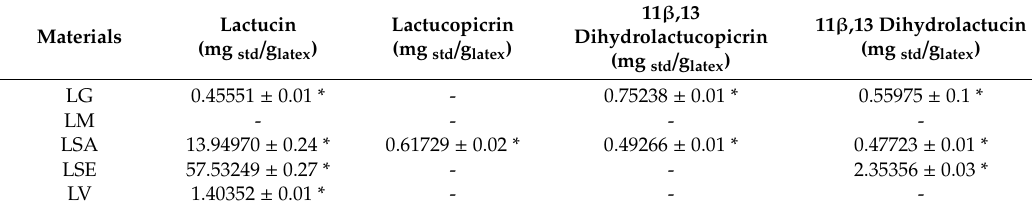
Table 3. HPLC analysis of the sesquiterpene lactones in the latexes from Lactuca